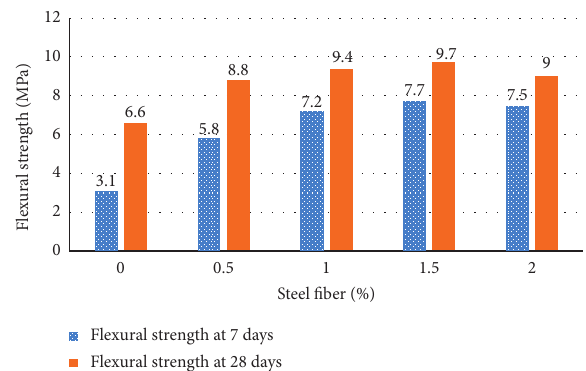
Figure 4: Results of flexural strength test at 7 and 28 days, with 20% slag at different concentrations of